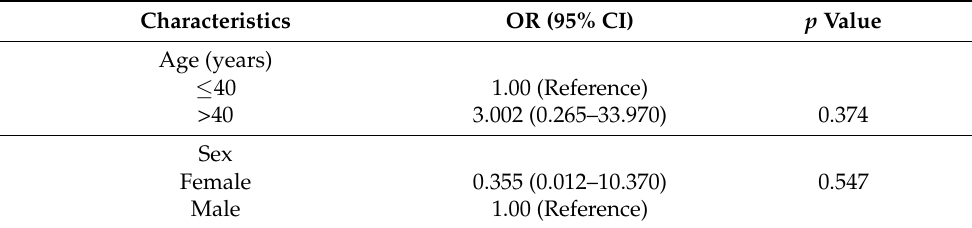
Table 2. Demographic and socioeconomic indicators as risk factors for high